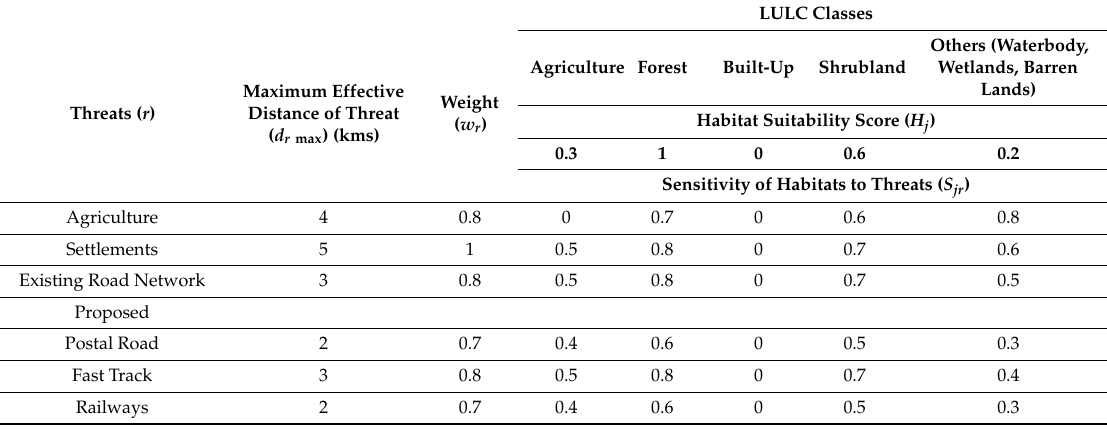
Table A1. InVEST Data Parameters for threats, maximum distance of threats, weight of threats, habitat suitability, and relative sensitivity of habitats to threats.